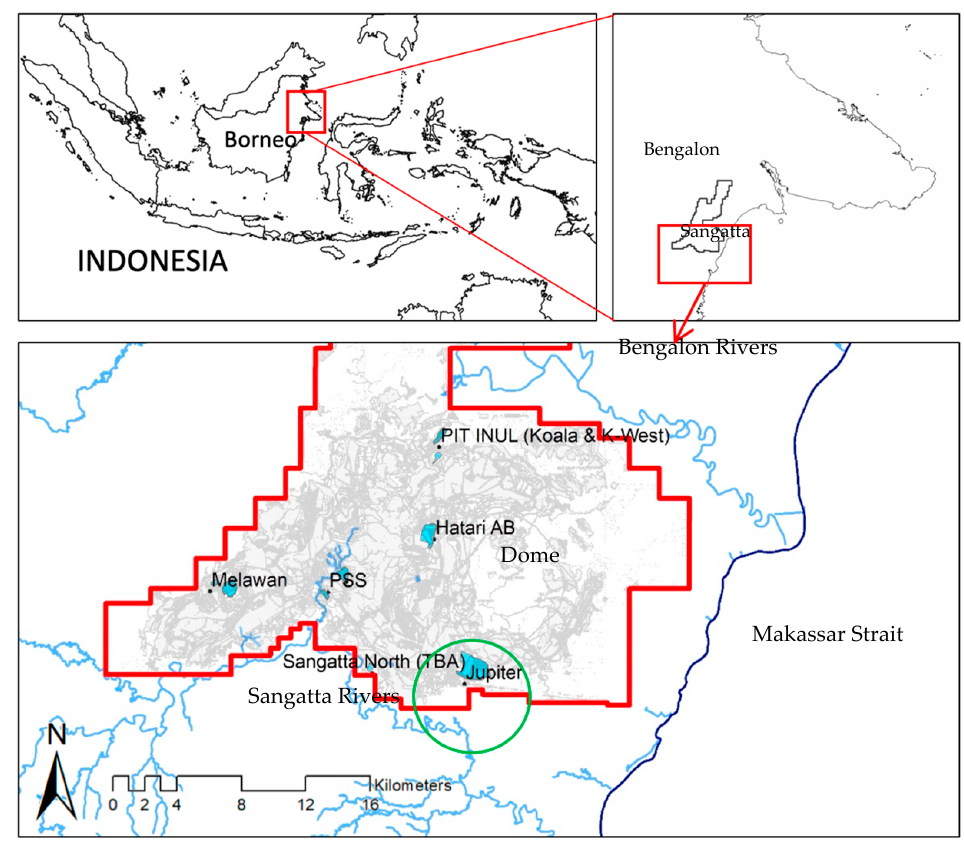
Figure 1. Study area.